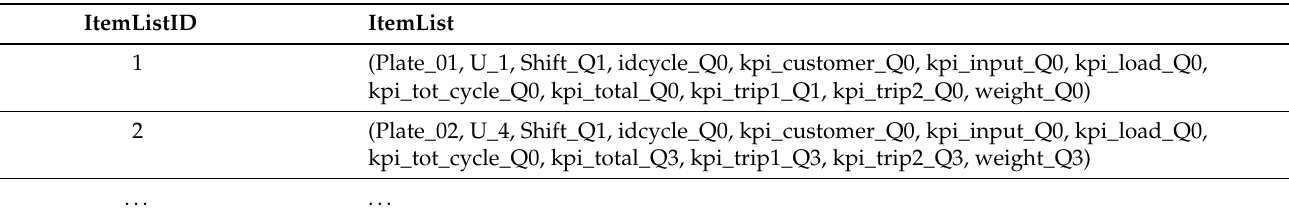
Table 3. Itemlist from the process records to be used for rule construction.